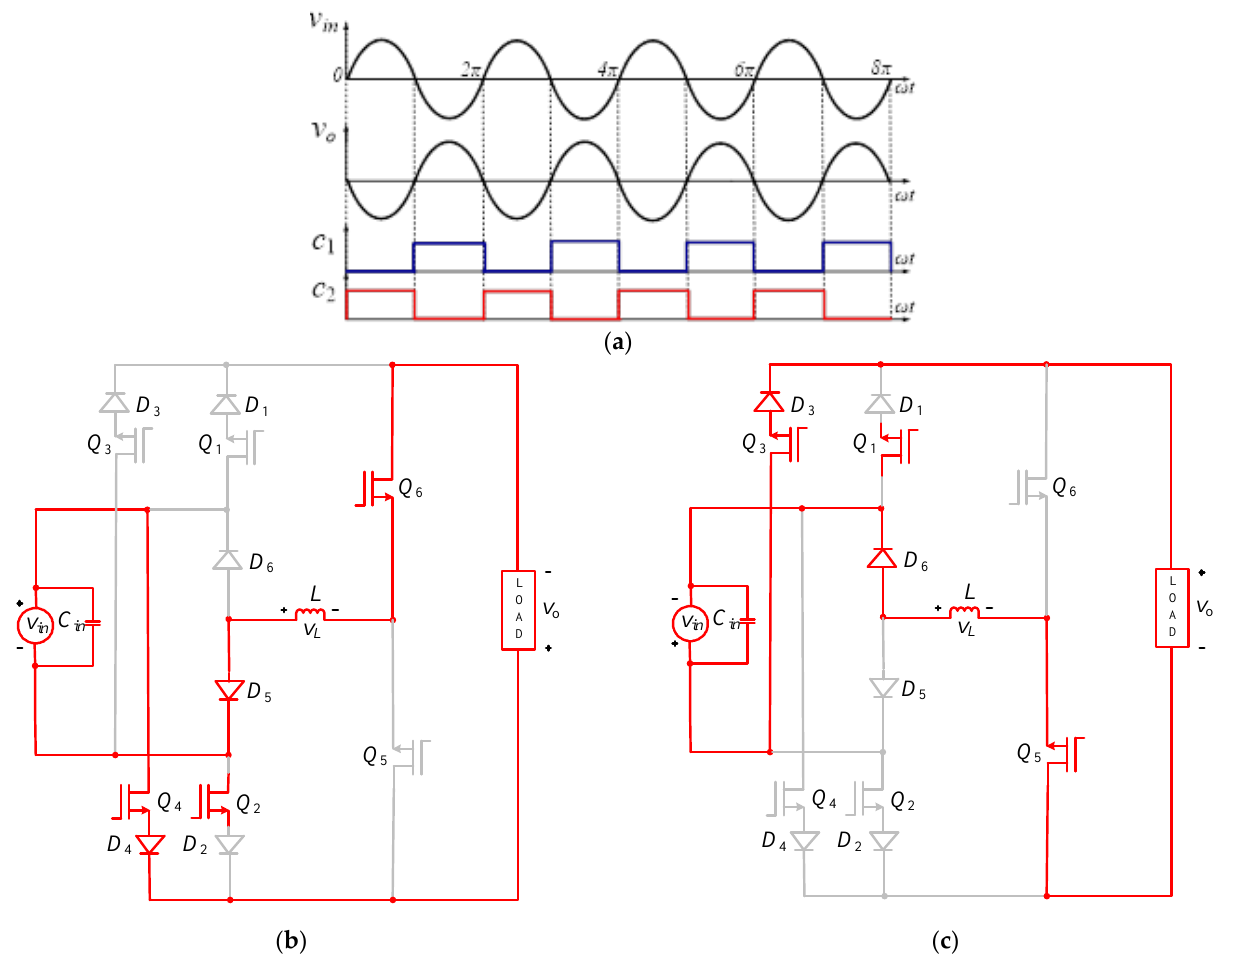
Figure 6. Voltage inverting operation: ( a ) switching control scheme; ( b ) current closed-loop during positive input; ( c ) current closed-loop during negative input.